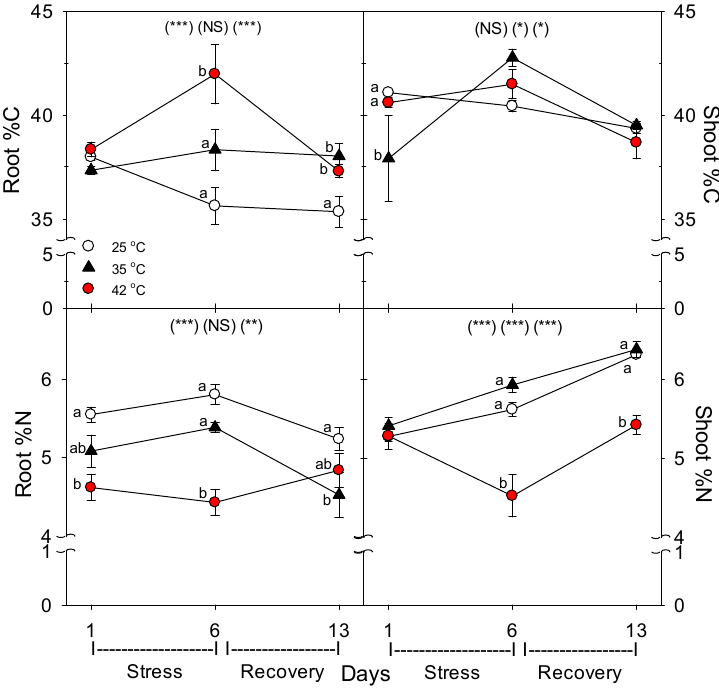
Figure 4. Effect of abrupt heat stress on the concentration of C and N in shoot (= leaves + stems) and roots of tomato (dry mass basis). Plants were grown at 25 °C/20 °C day/night (control), and then subsets of plants were heat stressed at 35 °C/30 °C or 42 °C/37 °C day/night for one or six days (maximum root temperatures = 32 °C or 39 °C), and then returned to control conditions for seven days of recovery (=day 13). Values are means ± 1 SE for four independent replicates from each harvest (days 1, 6, 13). Statistics are as in Figure 1. * p < 0.05, ** p < 0.01, *** p < 0.001.